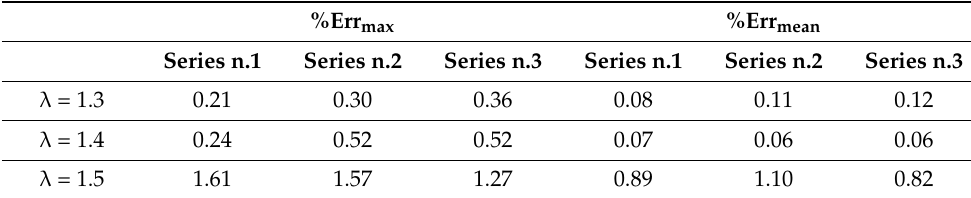
Figure 13. Experimental predicted trends of the predicted cases against the target ones at each λ value analyzed. The target curves have not been given with error bars because it would be difficult to emphasize the predicted trend. Table 6. Percentual errors of the predicted cases at each λ value analyzed.